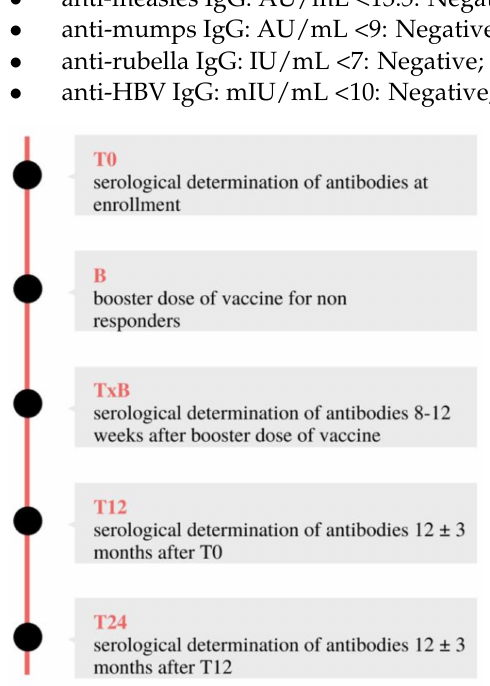
Figure 1. Testing and vaccine booster